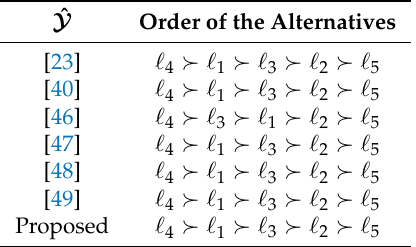
Table 14. Order of alternatives using different